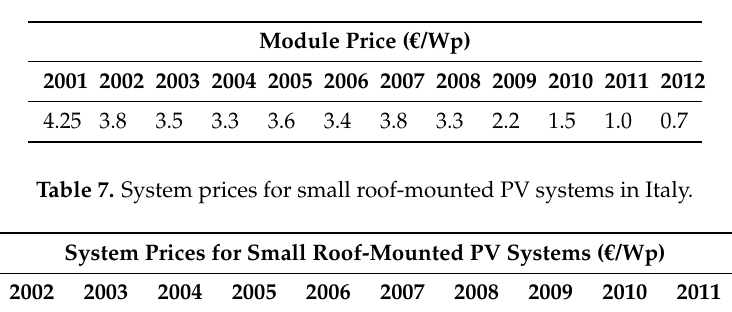
Table 6. PV module prices for Italy from 2001 to 2012.